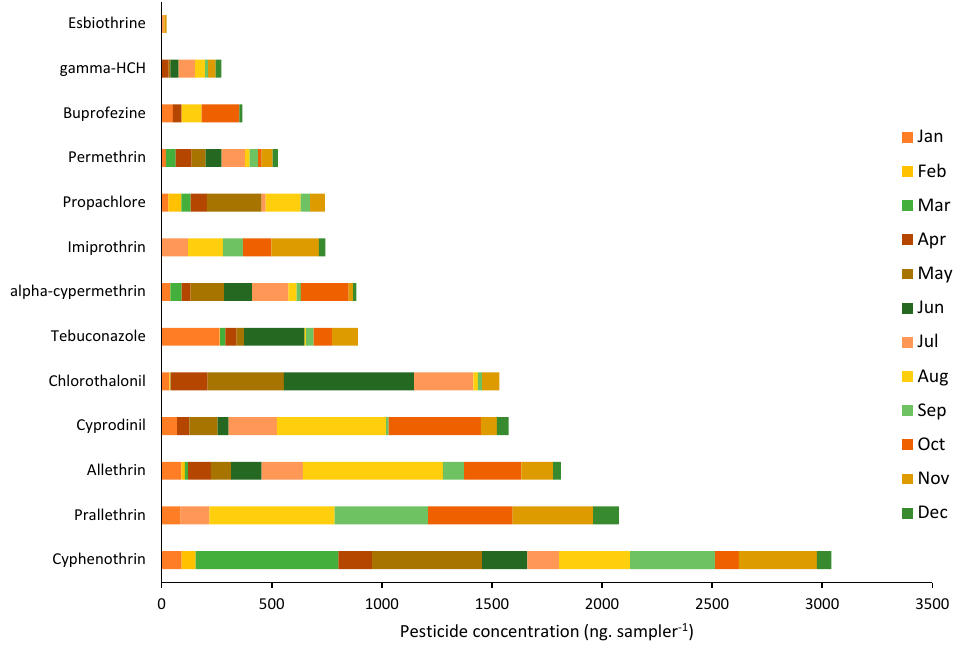
Figure 3. Variation of the concentration of the pesticides detected in the air samples collected from the living rooms of the targeted houses during the one-year sampling campaign (data are shown as per average concentration of pesticides detected in the nine residences per month).